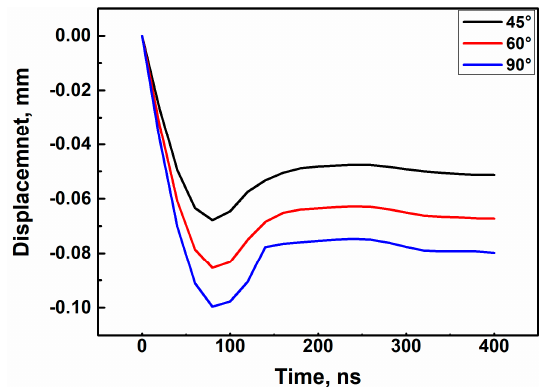
Figure 8. Displacement of the TiN/Ti coatings during impact.